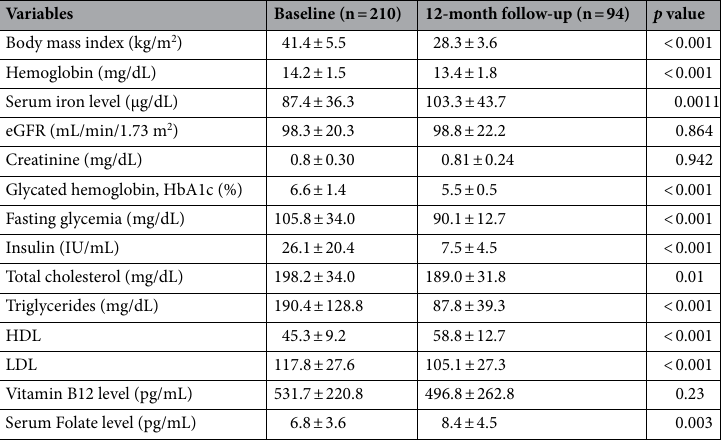
Table 2. Body mass index, kidney function, metabolic profiles and micronutrition at 12-month follow-up. eGFR estimated glomerular filtration rate, LDL low-density lipoprotein, HDL high density lipoprotein, Data are presented as mean ± standard